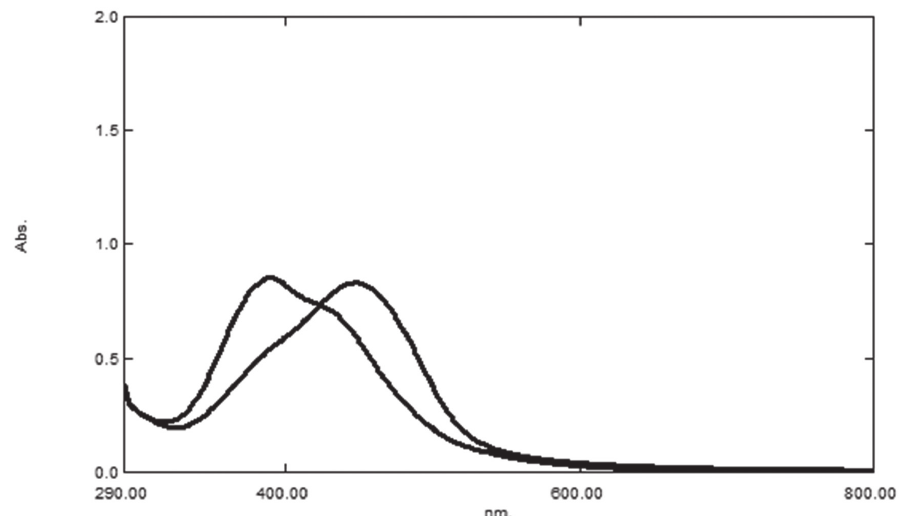
Figure 13: Effect of pH on 4-BPAP, selected spectra from Figure 12 which shows isobestic point at 365